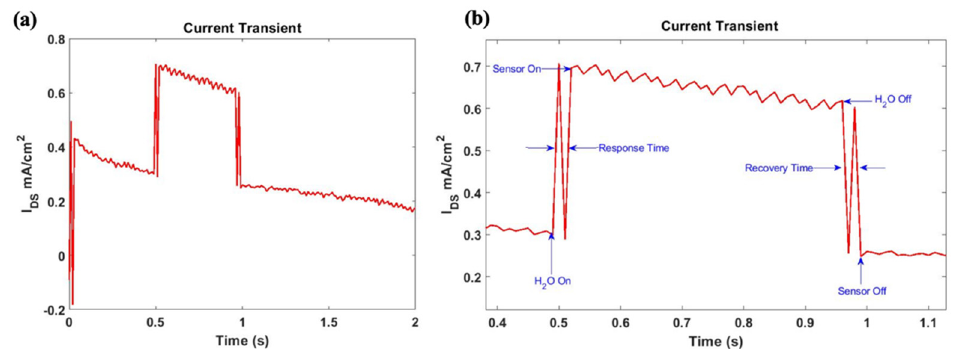
Figure 7 . (a) Transient response from OTFT humidity sensor before, during and after exposure to surface wetness with device architecture: L = 15 μ m and W = 300 μ m. (b) Humidity sensor response illustrating the current transient, response time, and recovery time of the sensor.